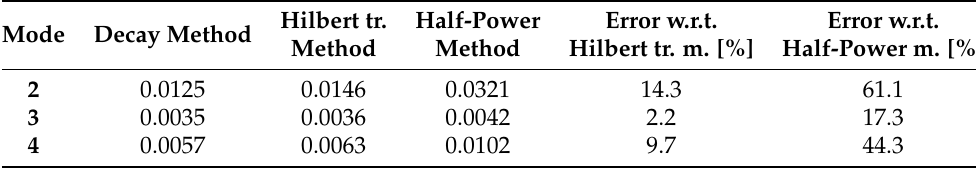
Table 4. Estimation of the damping ratio ξ i , j for the Actuator 1 compared with Hilbert transform and Half-power